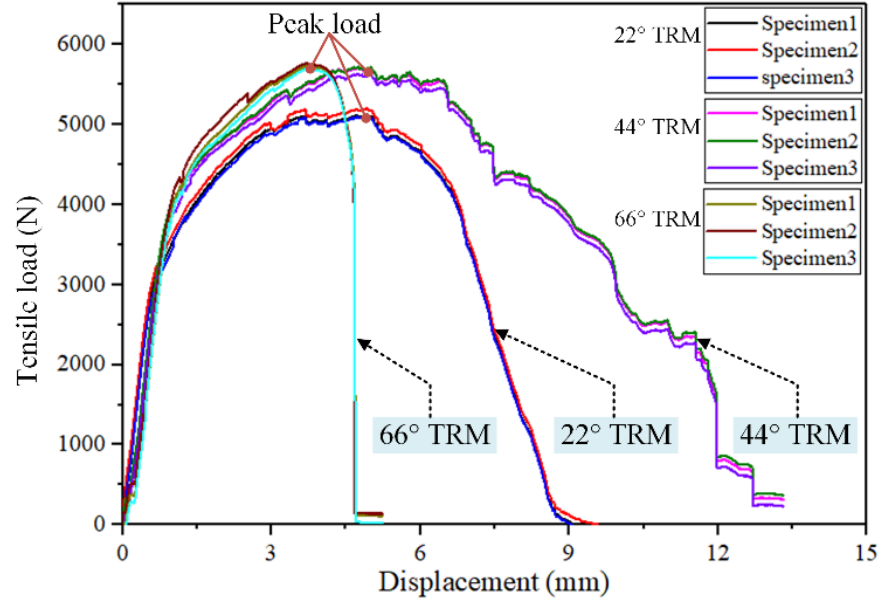
Figure 12. The tensile load-displacement curves with different TRM angles.